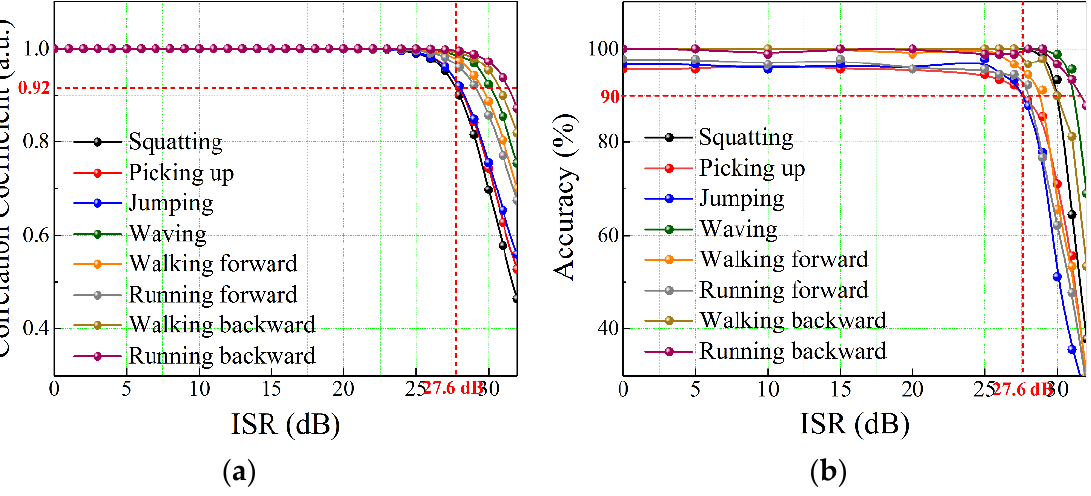
Figure 13. Variation curves of ( a ) CC and ( b ) recognition accuracy for eight activities with the increase in ISR.